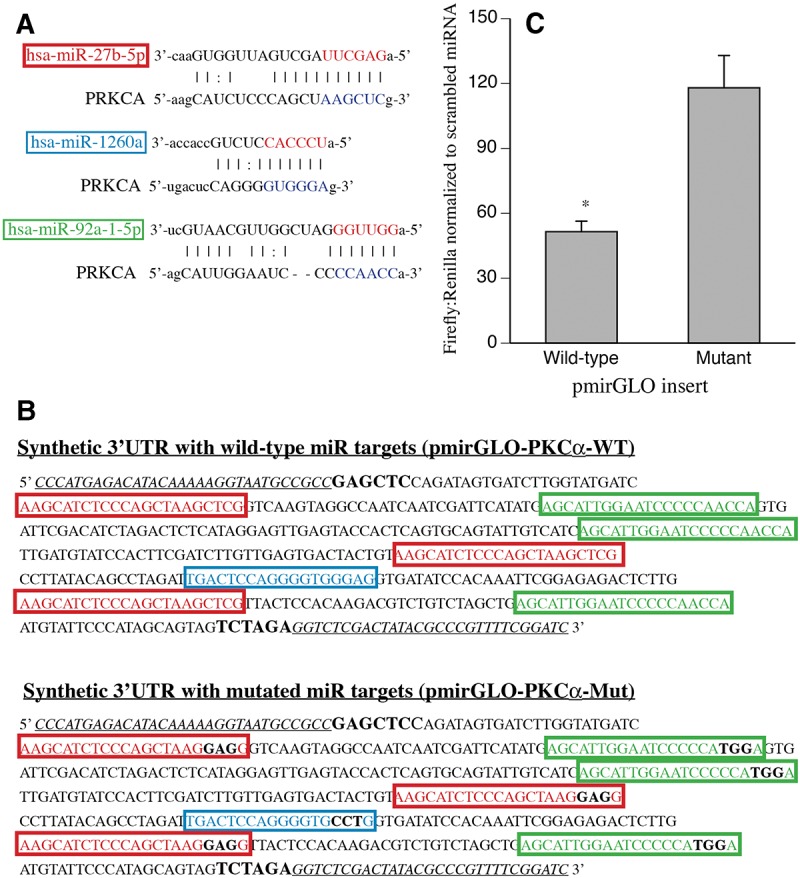
Functional analysis of the PKCα 3′ UTR binding sites for the temperature-sensitive miRNAs. (A) The putative binding sequences for hsa-miR-27b-5p, hsa-miR-1260a, and hsa-miR-92a-1-5p in PKCα 3′ UTR are shown. (B) Sequence of pmirGLO-PKCα-WT or pmirGLO-PKCα-Mut generated by cloning repeats of the putative miR binding sites or mutated sequences, respectively, into pmirGLO. The mutated nucleotides in each miR target sequence is indicated by black text for pmirGLO-PKCα-Mut. (C) HEK 293T cells were transfected with a combination of synthetic miRNA mimics for hsa-miR-27b-5p, hsa-miR-1260a, and hsa-miR-92a-1-5p or an equal concentration of non-targeting scrambled control mimic and pmirGLO-PKCα-WT (wild-type) or pmirGLO-PKCα-Mut (mutant), incubated at 37°C for 24 h, and dual luciferase assays were performed. Mean ± SEM. (*) P < 0.05, n = 4.